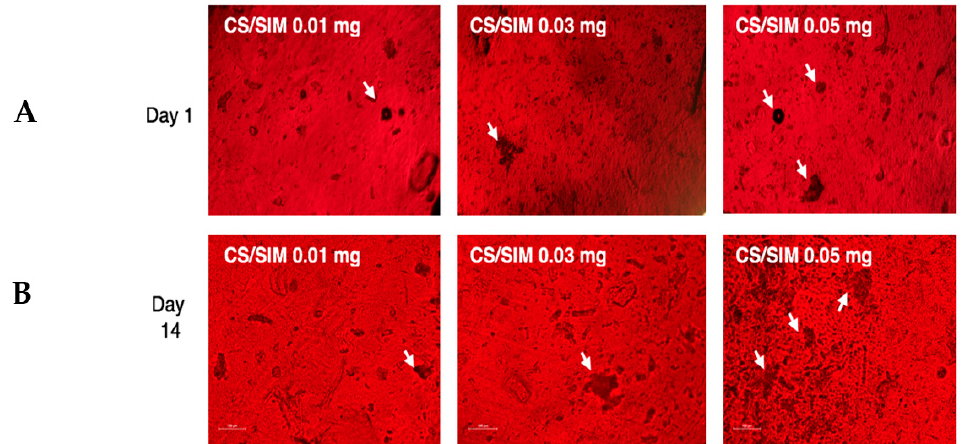
Figure 4. Alkaline phosphate activity for the SIM dose response on day 1 and 14. ALP, alkaline phosphate activity; CS, chitosan; SIM, simvastatin.